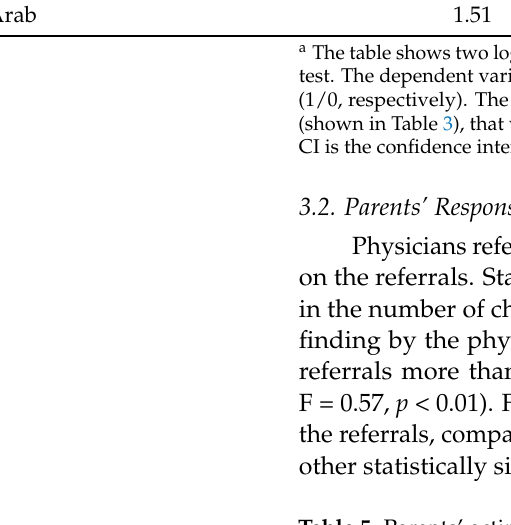
Table 5. Parents’ acting on physician’s or nurse’s referral a